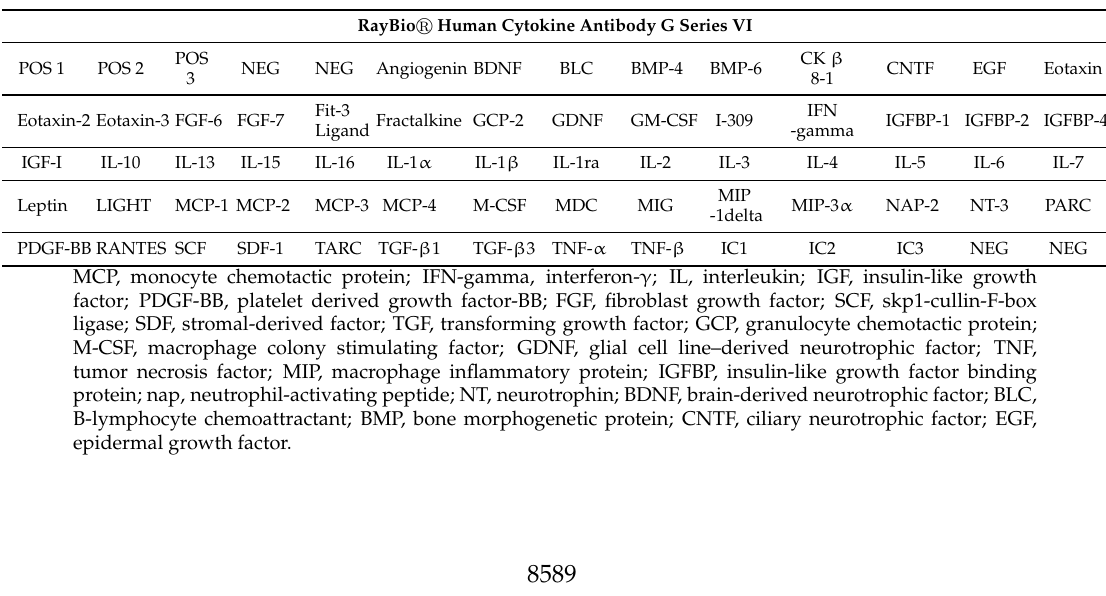
Table A1. The cytokine profiles were analysed with a semiquantitative human cytokine antibody array that detects 60